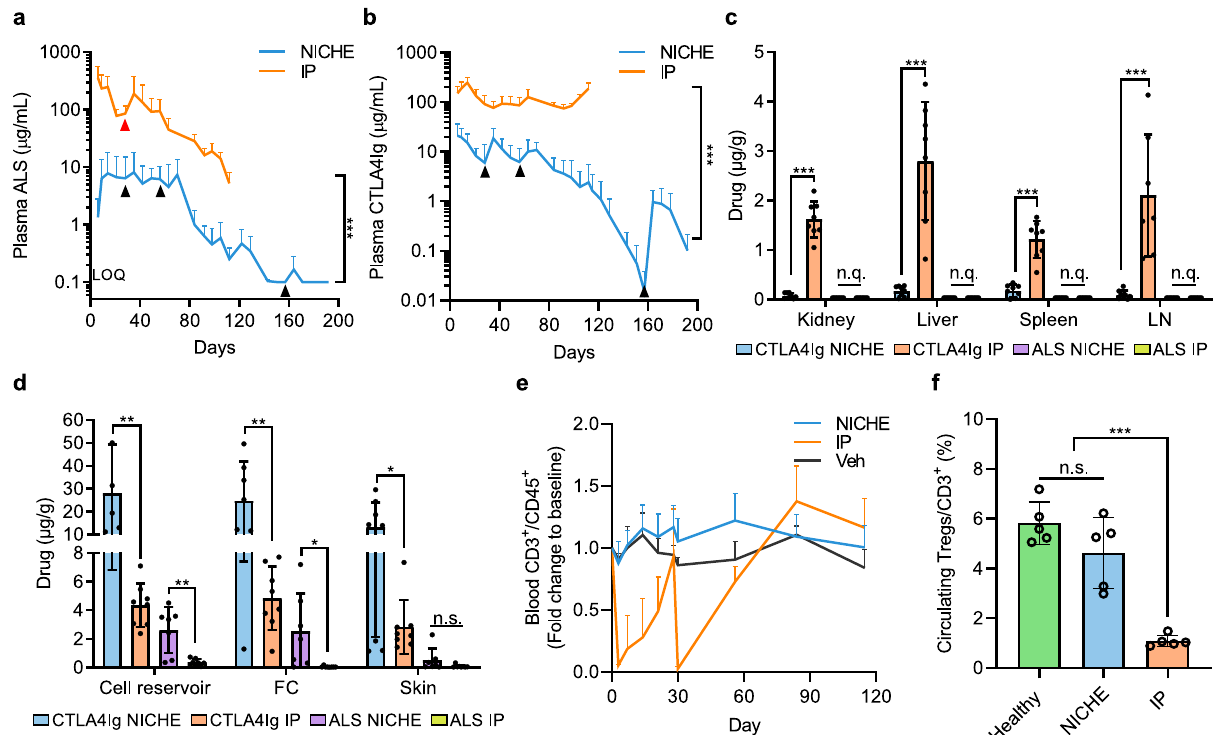
Fig.5|Drugbiodistributionandsystemicimmunosuppression. Plasmalevelsof a ALSand b CTLA4IgofNICHE( n =12today63, n =8today92, n =5today112, n